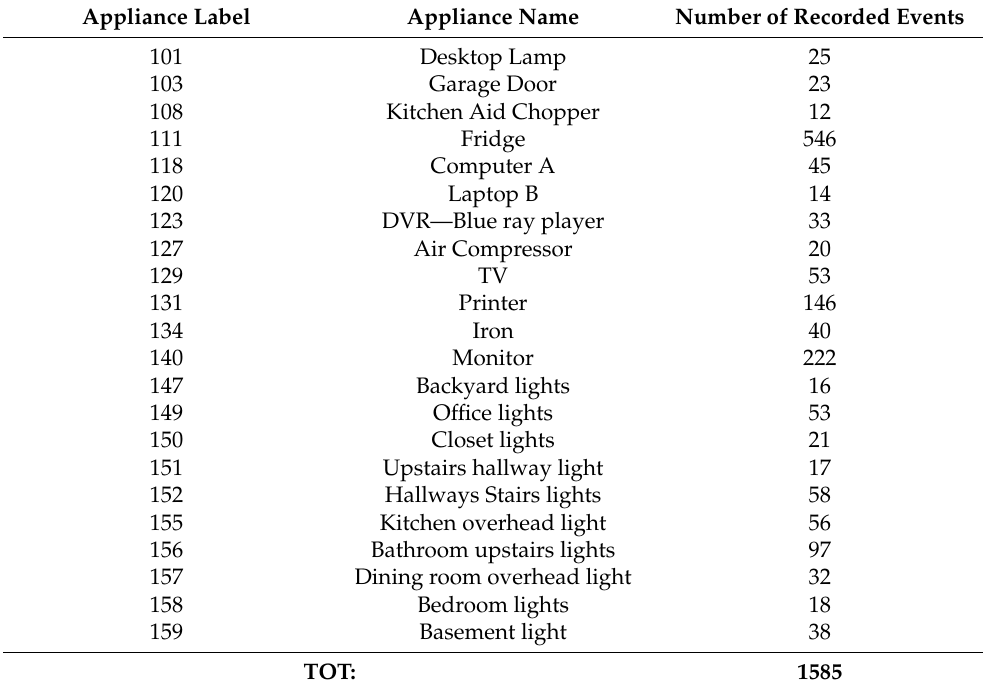
Table 2. Lists of the considered appliances from BLUED dataset.